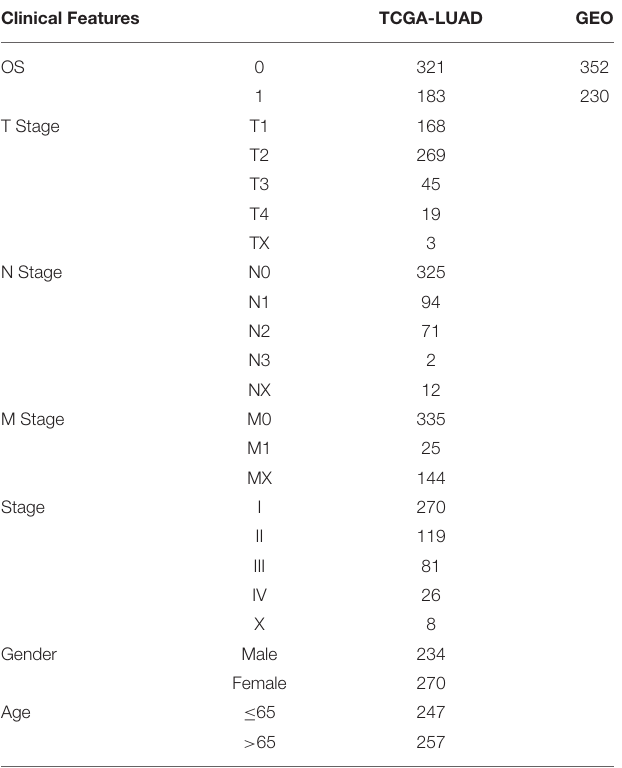
TABLE 1 | Sample clinical statistics for LUAD patients from TCGA and GEO